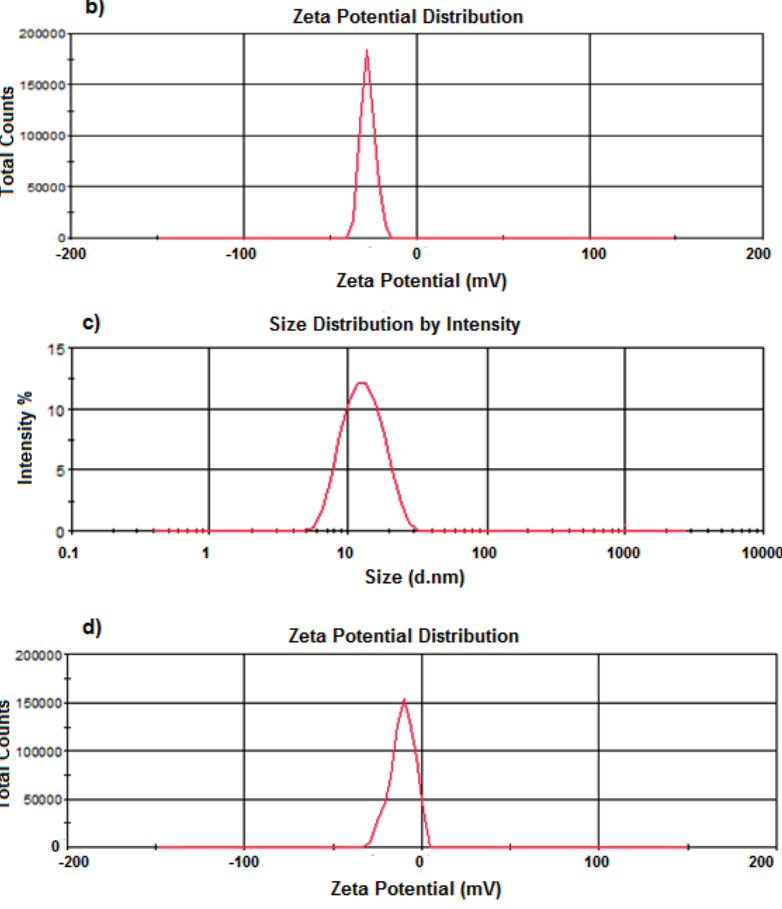
Figure 8. Distribution profiles of ( a ) size and ( b ) zeta potential of drug-loaded